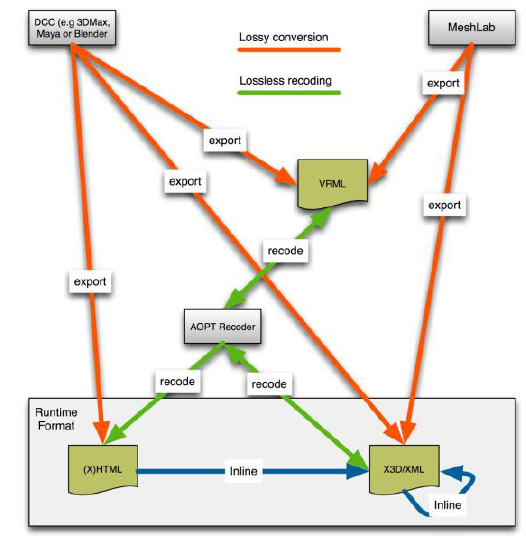
Figure 6. Interactive tools to export and recode data for X3DOM. MeshLab, as one major VH tool, can export X3D data directly, which can be used without further manual